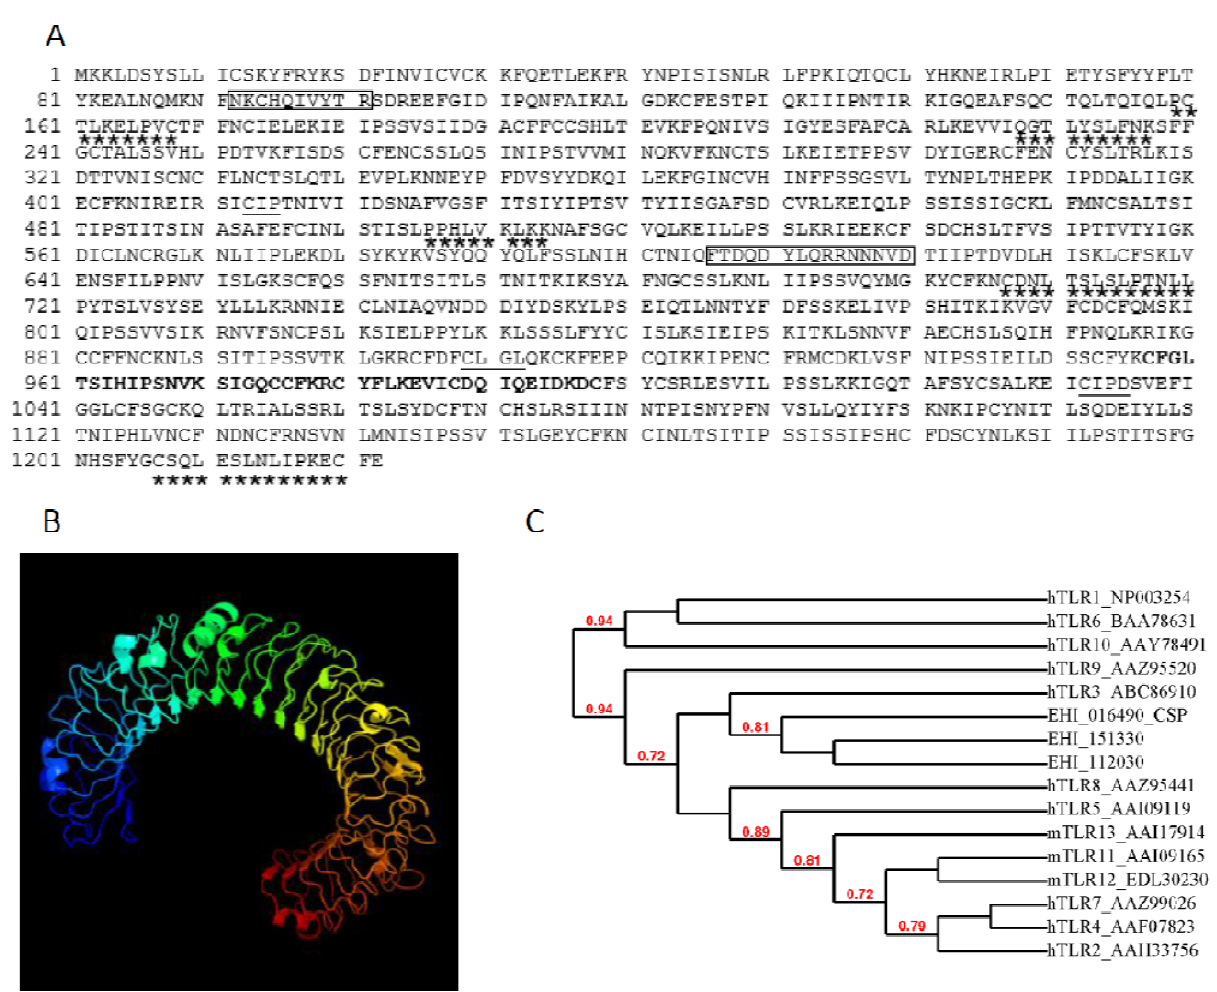
FIGURE 2: In silico analysis of the CSP (EHI_016490) amino acid sequence. (A) Protein domains found in the amino acid sequence of EHI_016490 after scanning with InterProScan and SMART online tools. The TNFR_NGFR_1 family's cysteine-rich region signature is indicated in bold. The leucine-rich repeats (xxxLxxLxx) are underlined with stars, the prenylation sites (CaaX, where each “a” is an aliphatic amino acid) are underlined and the two peptides used to produce polyclonal rabbit serum are bordered. (B) A three-dimensional structure model of EHI_016490, generated using Phyre2. The model is based on the c1ziwA template (the structure of the human toll-like receptor 3 extra- cellular domain). In all, 856 residues (70% of the full sequence) were modelled with a confidence score of 99.9% for the highest-scoring template. (C) Dendogram showing the relatedness between EHI_016490, EHI_112030, EHI_151330 from Entamoeba histolytica , human TLR (hTLR) and murine TLR (mTLR). The number at each branch point represents percentage bootstrap support, calculated from 1000 replicates. Bootstrap values below 0.7 are not